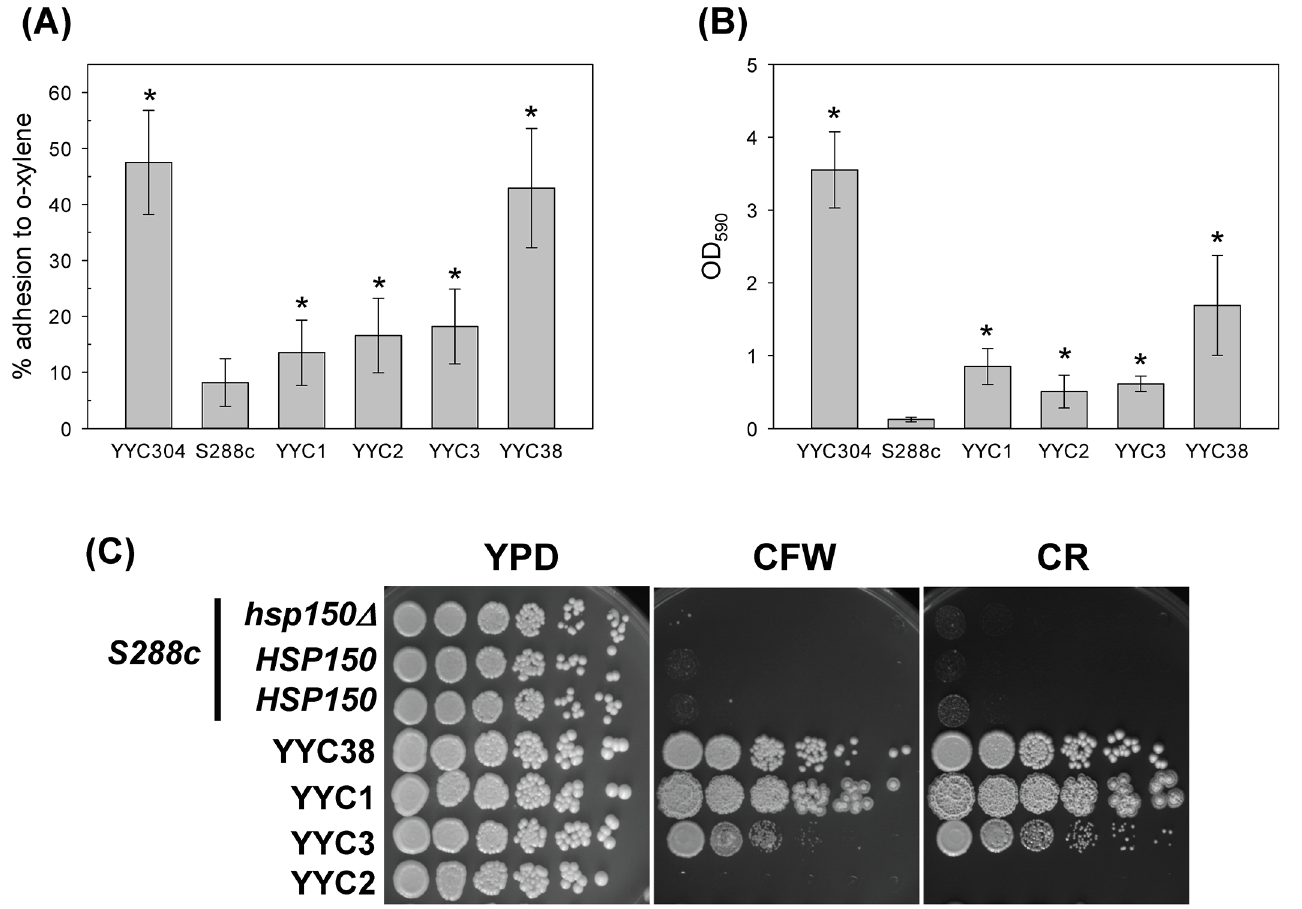
Fig 1. The S . cerevisiae clinical isolates showed hydrophobic cellular surface and resistant to cell wall-perturbing agents. Strains S288c and YYC304 were served as negative and positive controls respectively. The clinical isolates YYCs 1 – 3 and 38 were subjected to cell hydrophobicity assay (A), adhesion assay (B), and sensitivity assay with 50 μ g/mL CFW or 100 μ g/mL CR (C) as described. Serial 5-fold dilutions of each strain were spotted on solid YPD media or in the presence of CFW or CR. The plates were incubated at 30°C for 3 days. 3 biological replicates were performed. Asterisks indicate statistically significant differences from S288c ( p <